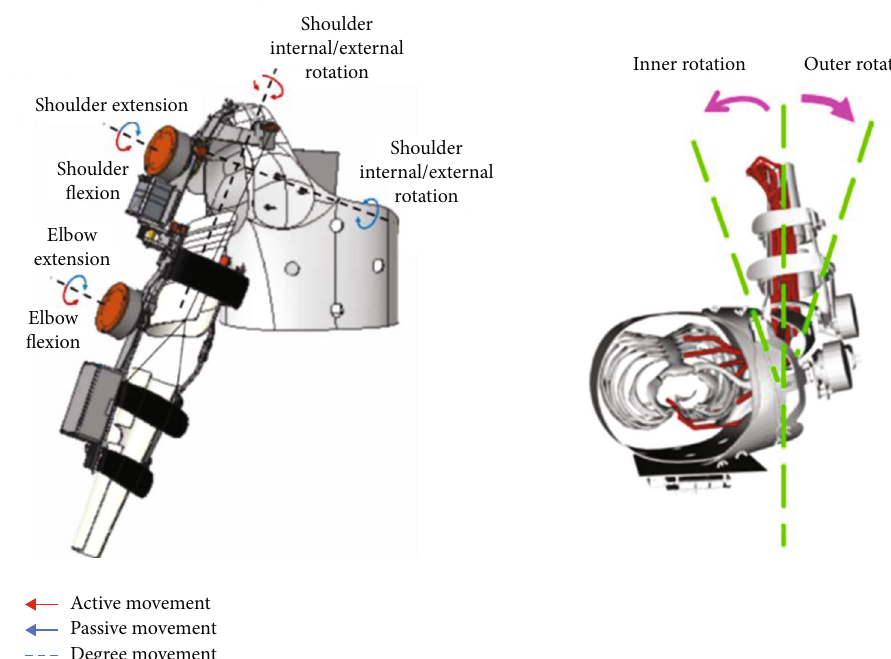
Figure 2: Assistive device motion range according to its degree of